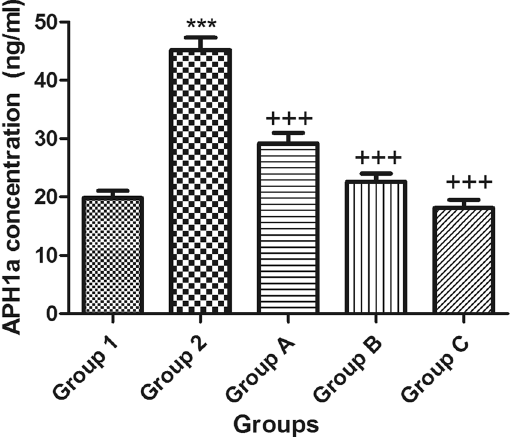
Figure 5. Effect of STZ, celecoxib, andgingerol (10 and 20 mg/kg) on the mean mouse APH1a concentration using an ELISA assay. Animals were divided into 5 groups. Group 1 received a single ICV dose of saline; then, after 2 weeks, animals were intraperitoneally injected with saline for seven days. Group 2 received a single injection of STZ (3 mg/kg, i.c.v.). and then, after 2 weeks, they were intraperitoneally injected with saline for 7 days. Group A was injected with STZ (3 mg/kg, i.c.v.) once, and after 2 weeks, they were injected with celecoxib (30 mg/kg, i.p.) for 7 days. Group B animals were injected with STZ (3 mg/kg, i.c.v.) once, and after 2 weeks, they were injected with gingerol (10 mg/kg/day, i.p.) for 7 days. Group C was injected with STZ (3 mg/kg, i.c.v.) once, and after 2 weeks, they were injected with gingerol (20 mg/kg/day, i.p.) for 7 days. Animals from